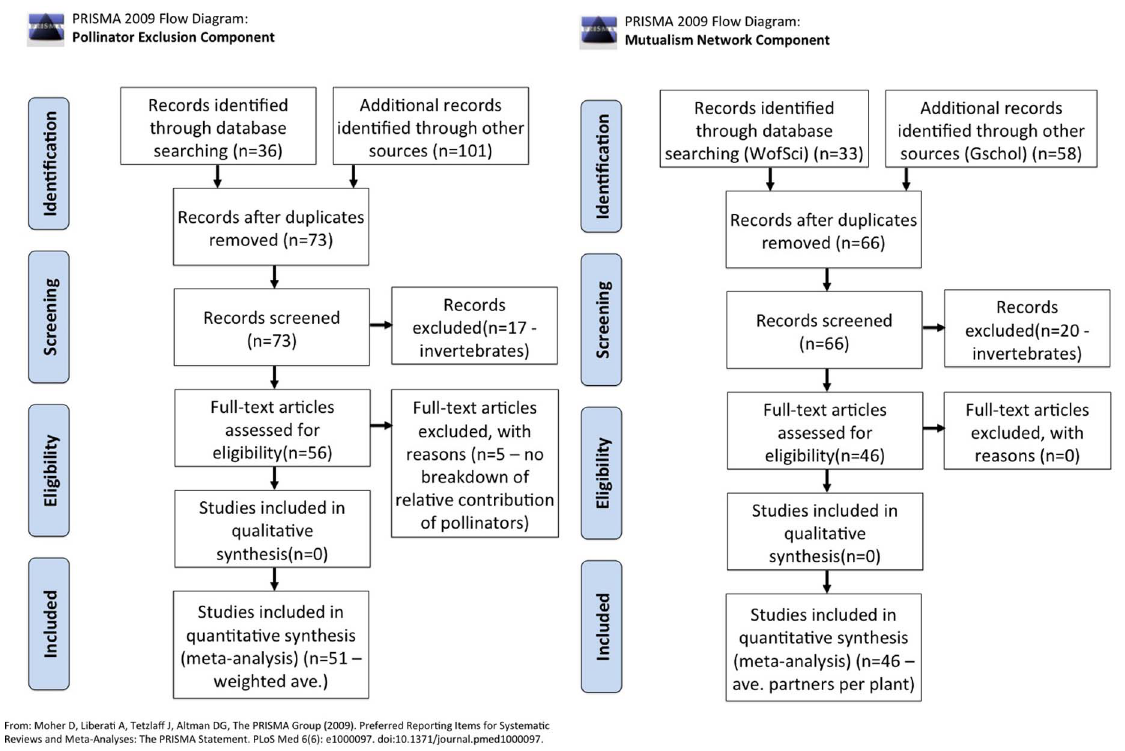
Figure 2. PRISMA flowchart providing the steps of data collection for this systematic review.